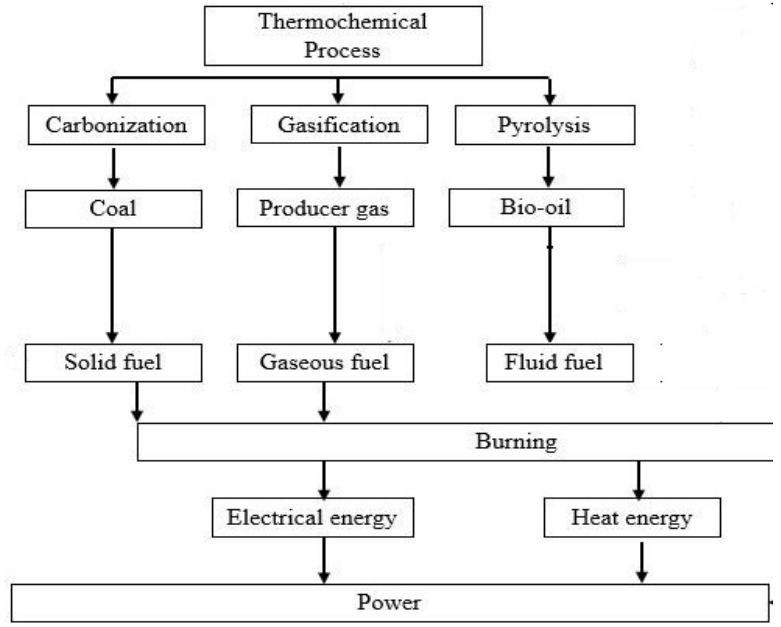
Figure 1. Thermochemical routes to energy.